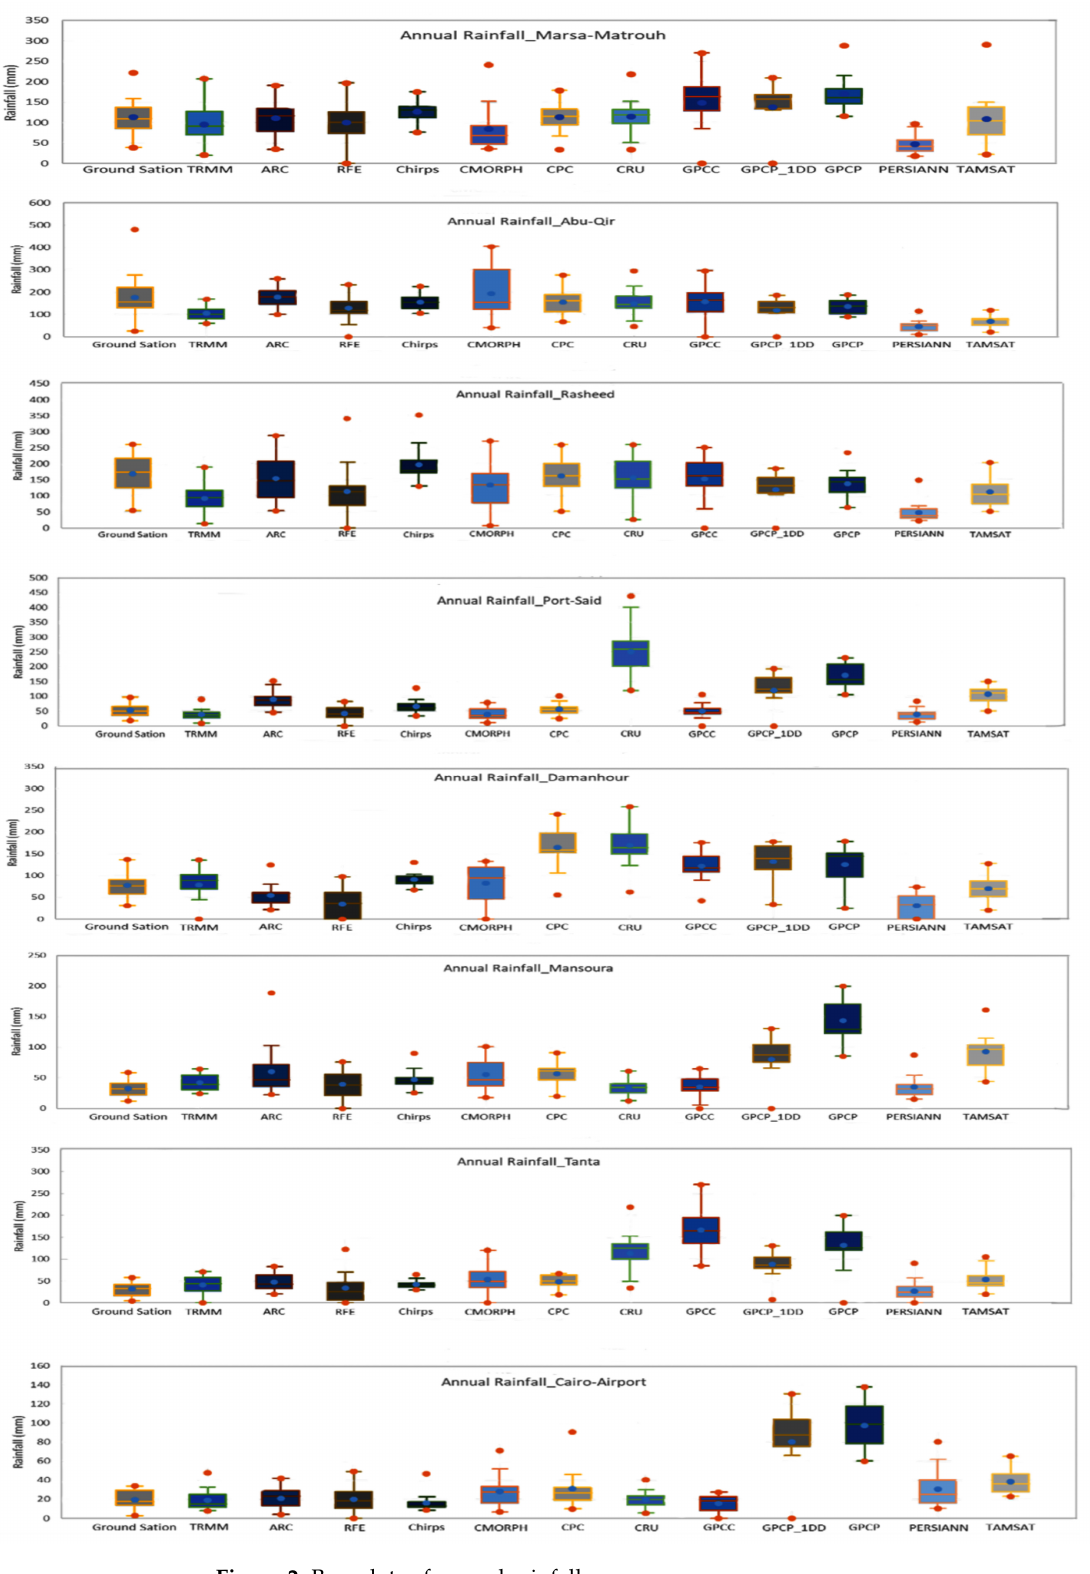
Figure 2. Box-plots of annual